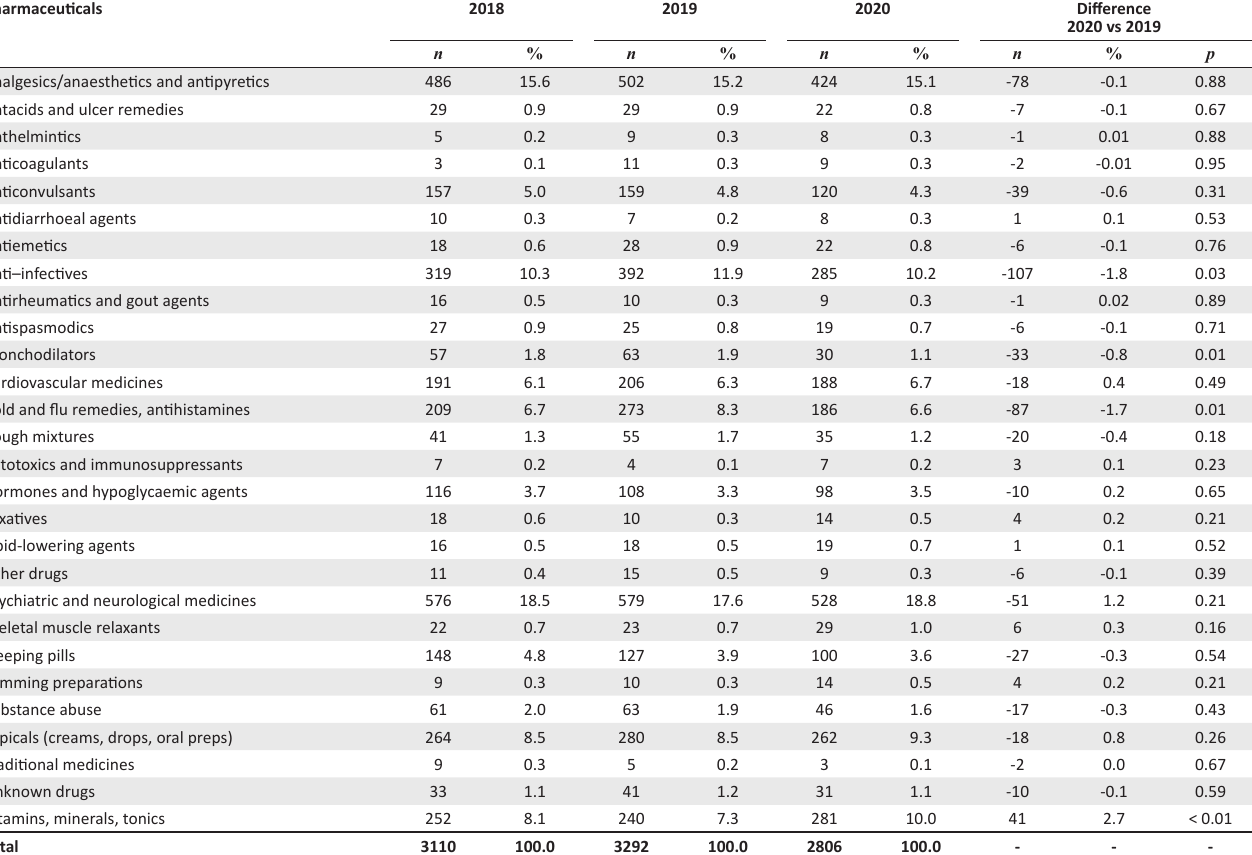
TABLE 1-A1: Pharmaceutical exposures received by the Poisons Information Helpline of the Western Cape during the first six months of the COVID-19 pandemic and similar periods during 2018 and 2019. Pharmaceuticals